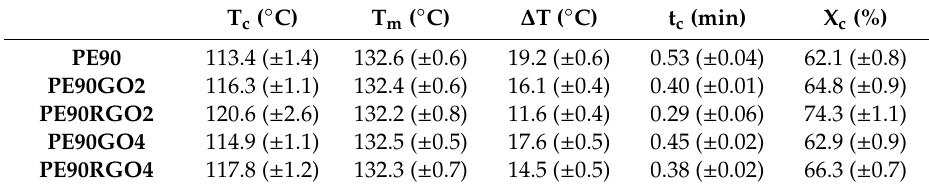
Table 3. Crystallization and thermal parameters of PE in unfilled and filled binary systems.